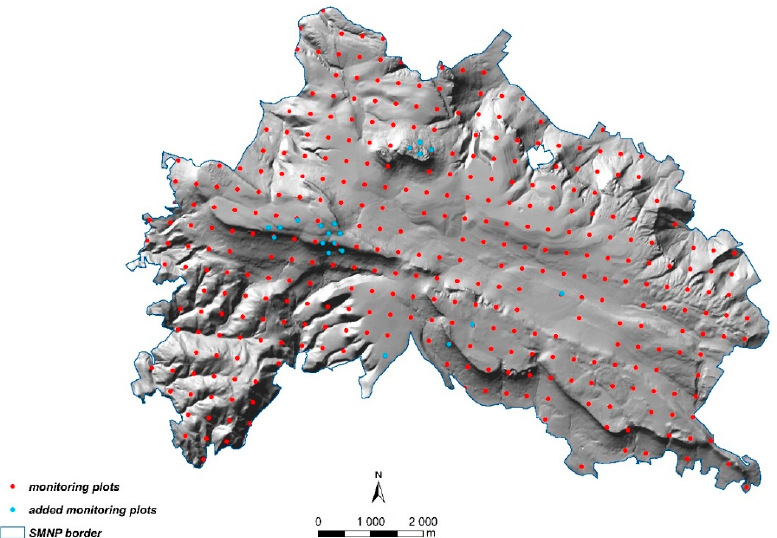
Figure 6. Location of 377 plots (red and blue circles) in the reduced and extended monitoring net- work (REMNet). Blue circles represent added monitoring plots. (REMNet). Blue circles represent added monitoring